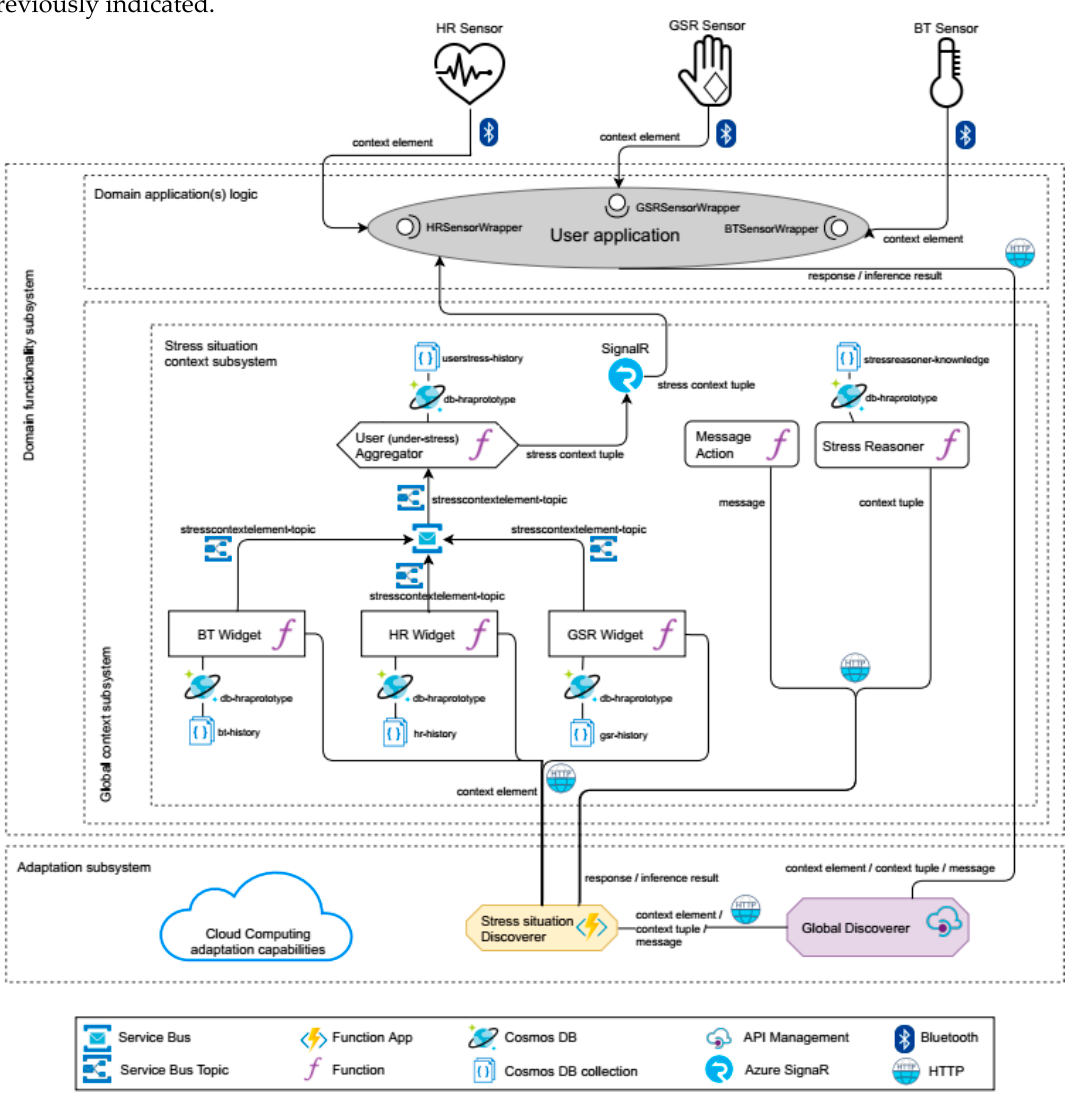
Figure 3. Detail of the prototype’s deployment in Microsoft Azure using its serverless functions and services (only the stress situation context subsystem implementation is